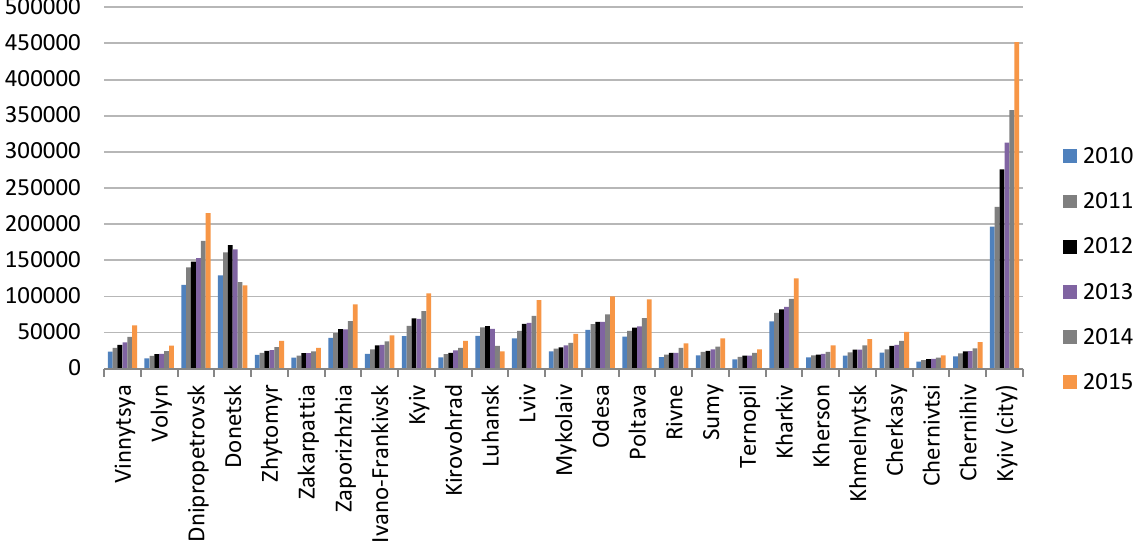
Fig. 1. The GRP by region in 2010 – 2015, million UAH at actual prices (based on data of the State Statistics Service of